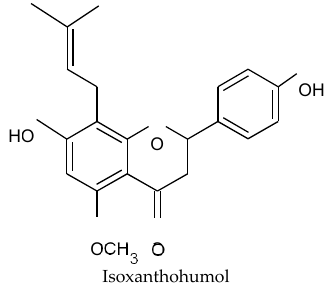
Figure 4. Structure of isoxanthohumol.